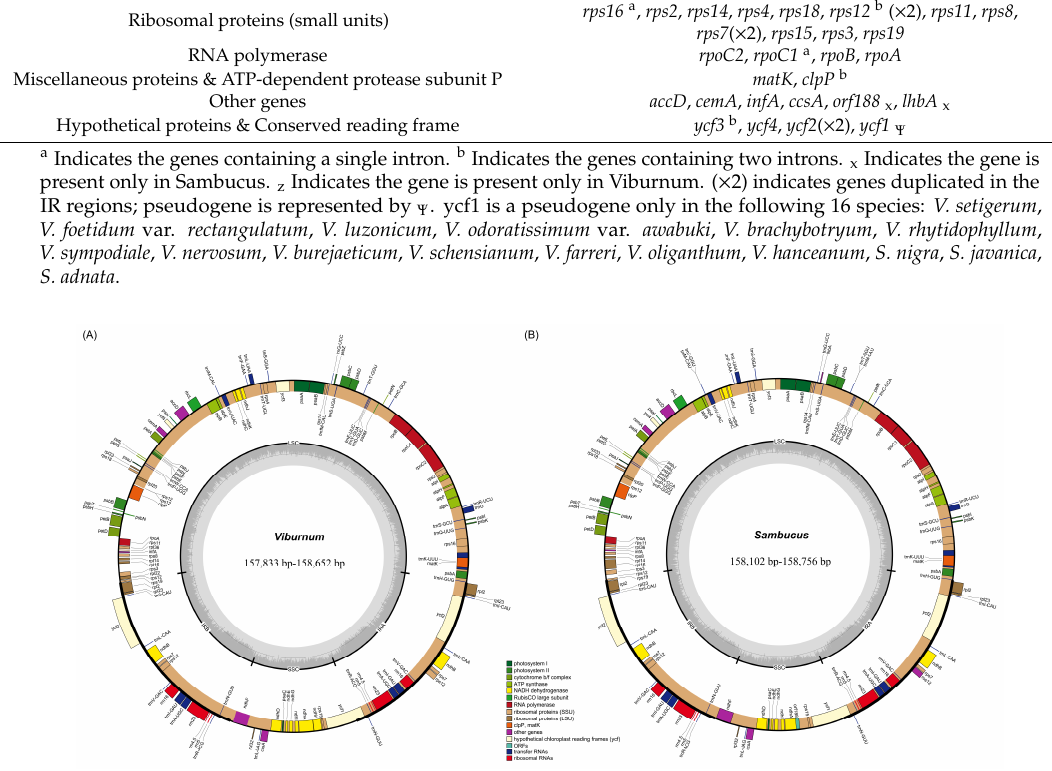
Figure 1. Chloroplast genome maps for ( A ) 21 Viburnum species and ( B ) 3 Sambucus species.